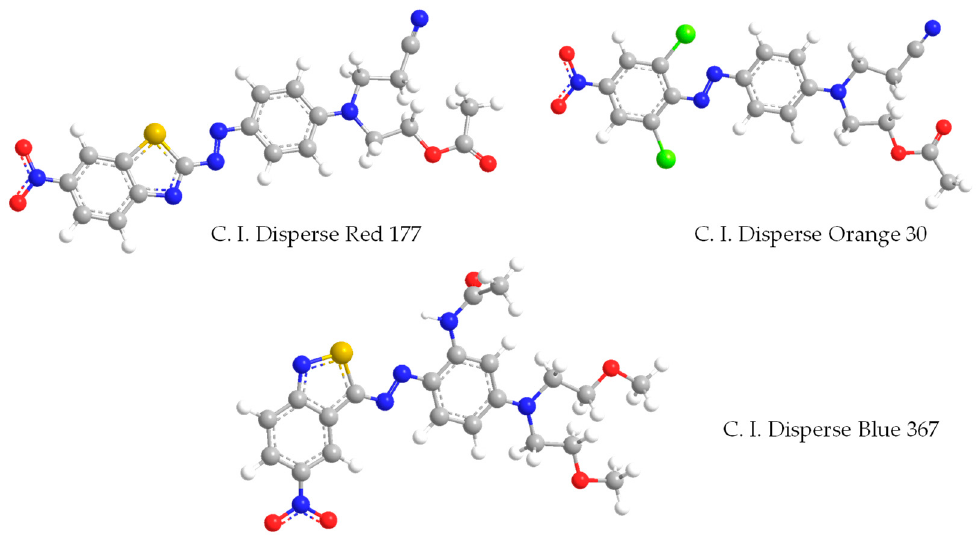
Figure 2. Molecular Structures of disperse dyes.